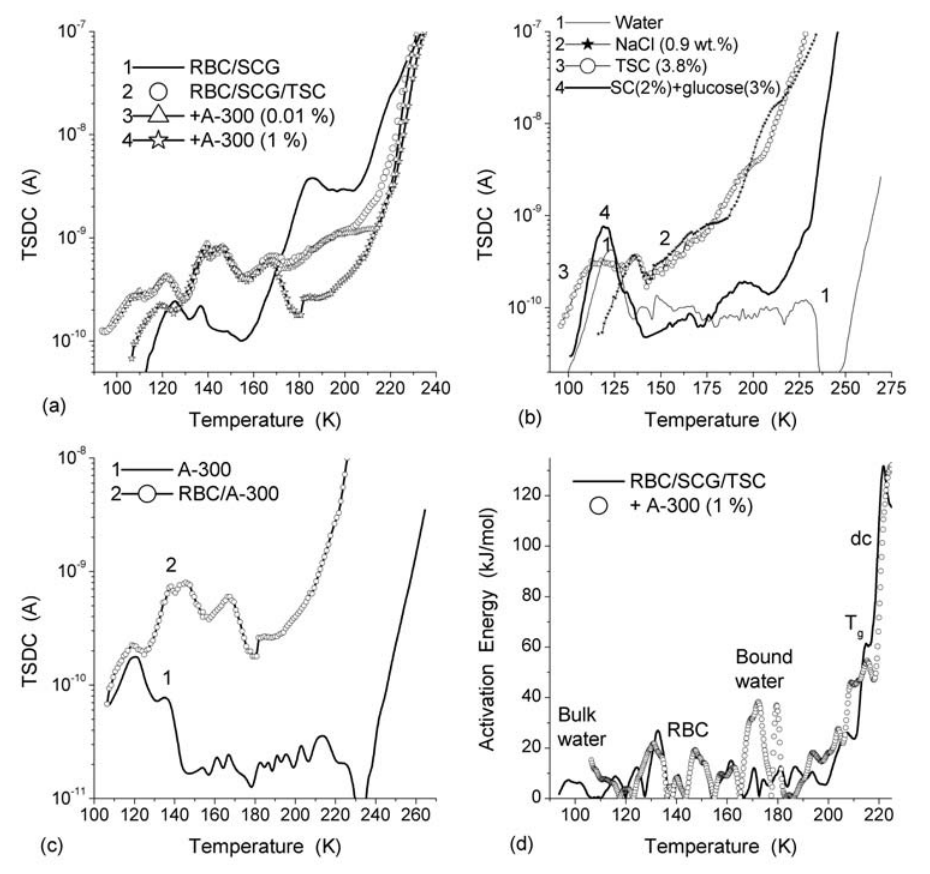
Fig. 6 TSDC thermograms of (a) RBCs in the buffers with trisodium citrate (TSC) and sodium hydrocitrate with glucose (SCG) and on interaction with nanosilica A-300 at C . 01 and (a) 1.0 wt.%, (b) pure water and different buffer solutions; (c) A-300 A − 300 = 0 (in water) and RBC/A-300 (in the buffer) at CA-300 = 1.0 wt.%; and (d)